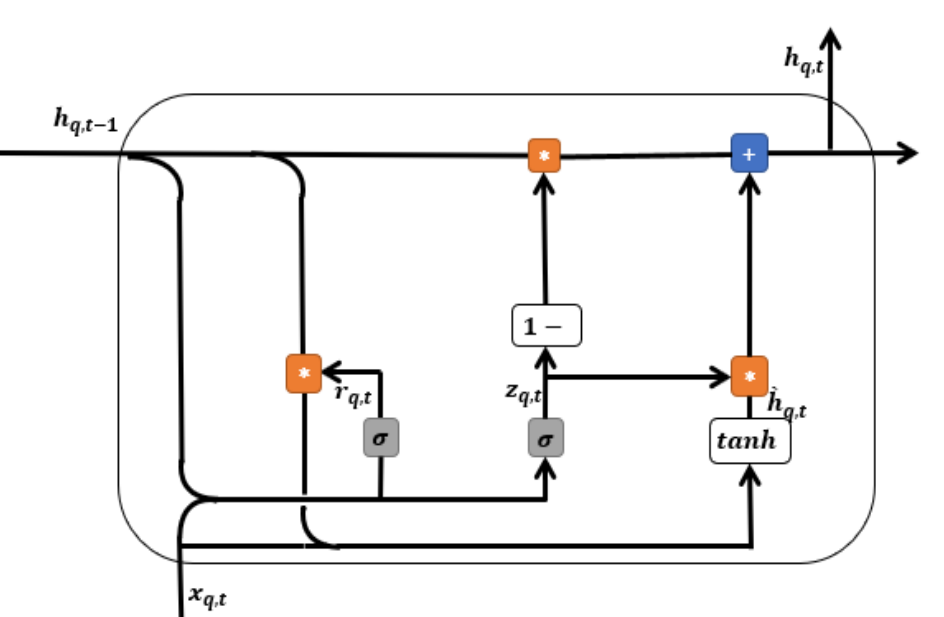
Figure 2. Cell structure of the Quaternion Gated Recurrent Unit (QGRU).